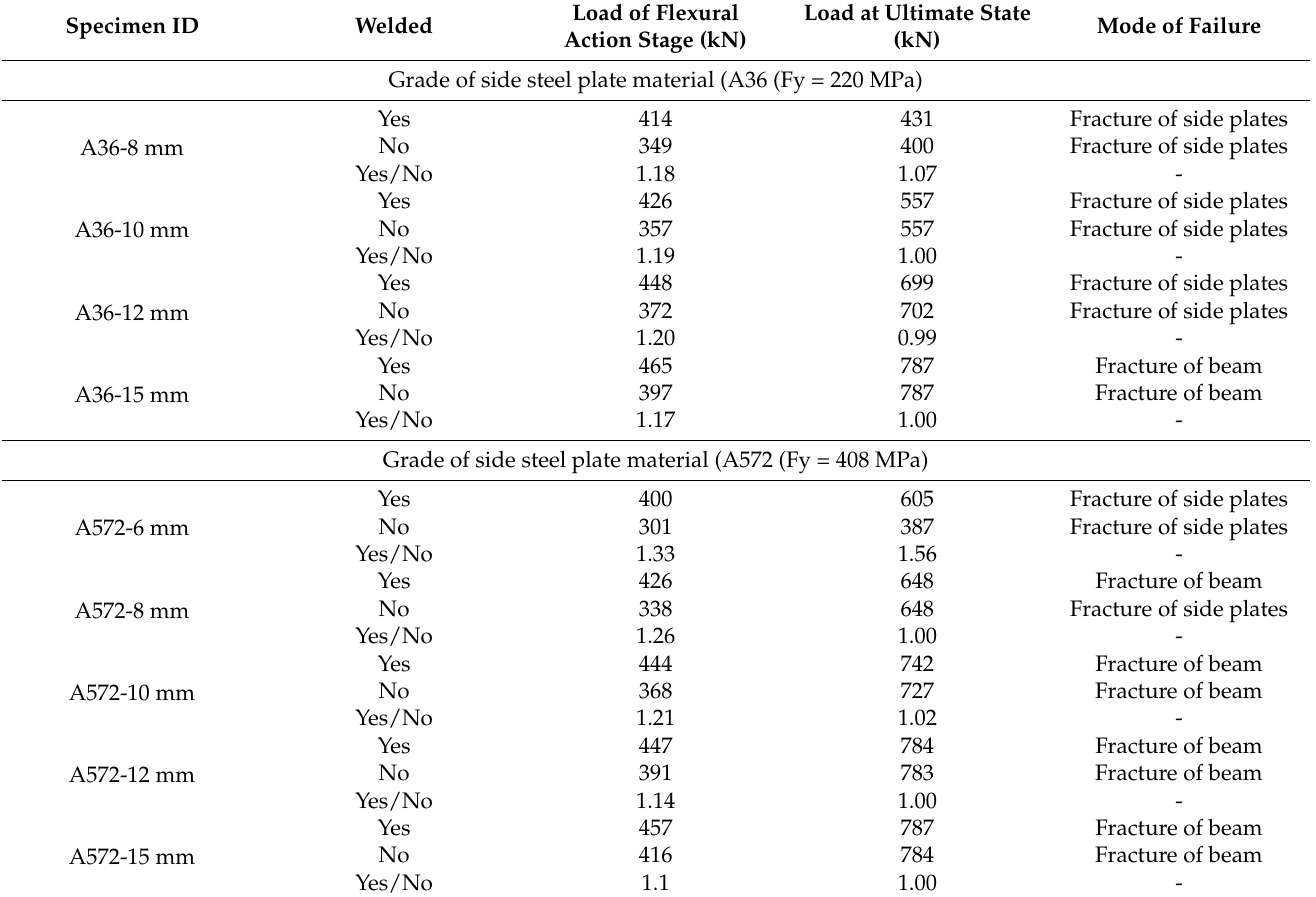
Table 7. Comparison of FEM findings from specimens used in the investigation